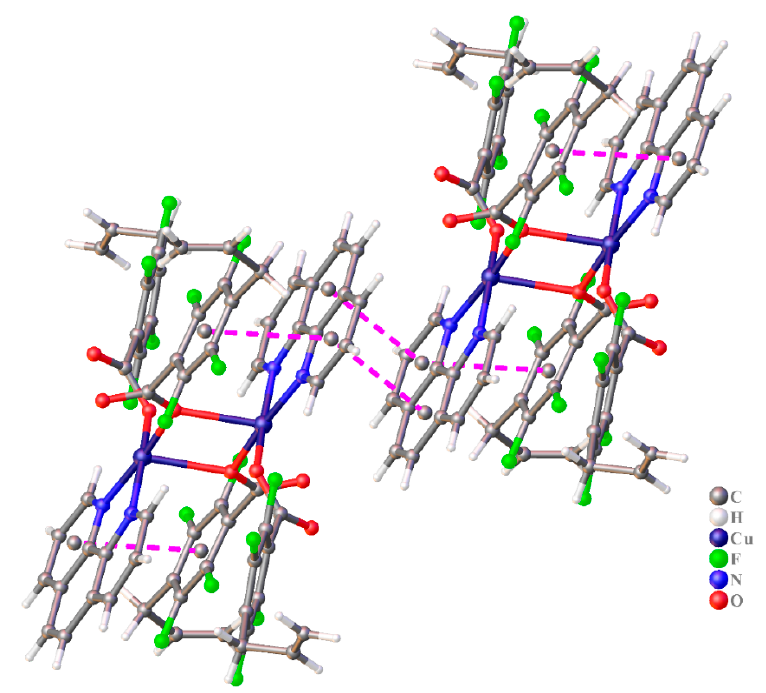
Figure 6. Intra- and intermolecular π ··· π interactions in a crystal of compound 5